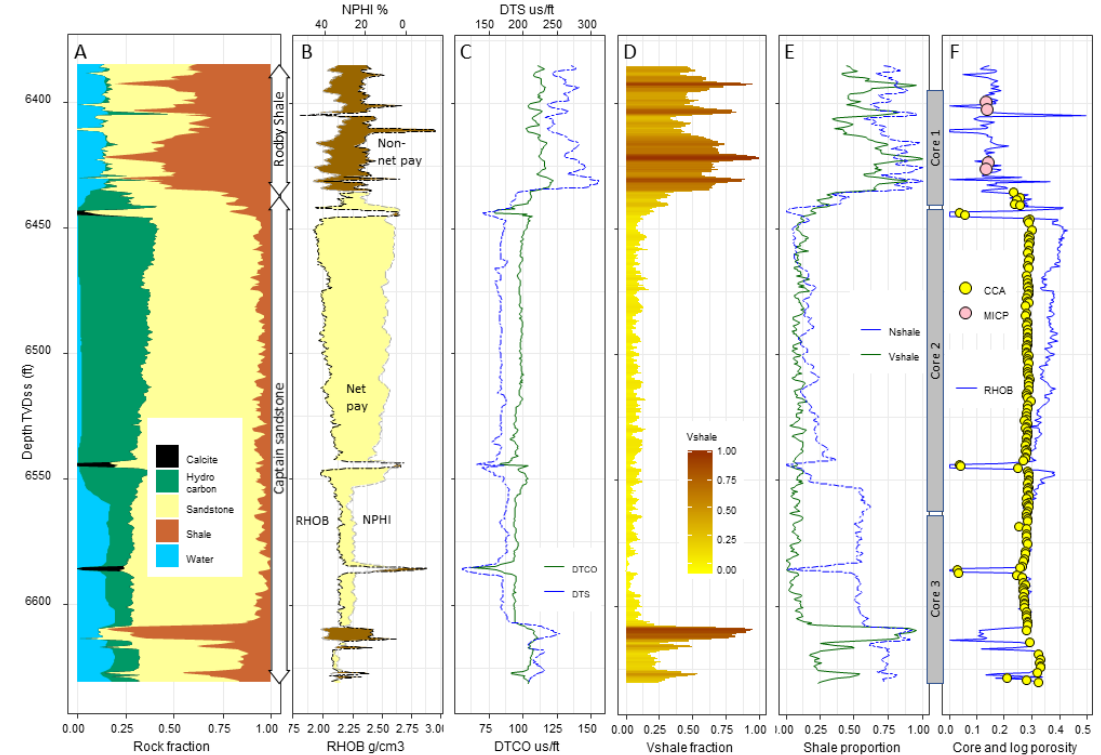
Figure 4. Wireline log raw and interpreted data from well 14/26a-8 from the Lower Cretaceous Acorn Storage Site. ( A ) Interpreted lithology and fluid saturation diagram showing the Captain Sandstone which is overlain by the top-seal of the Rodby Shale. In this well, the Rodby Shale seems to be very shale rich. The pre-production petroleum column extended up to beneath the Rodby Shale. The petroleum saturation seems to have been very high, suggesting that the top-seal was very effective. ( B ) Neutron-density crossover diagram confirming that the Rodby Shale is a good seal (non-net reservoir with extensive and wide crossover). ( C ) Sonic log data; compressional sonic (DTCO) and the compressional shear log (DTS). The higher ratio of DTS to DTCO in the Rodby Shale than the cleaner sandstone reflects the lower Young’s modulus in the shale than the sandstone. ( D ) Vshale representation based on gamma ray logs. The highest Vshale sections equate to the weakest rocks (compare D to C ). ( E ) Vshale compared to Nshale, where the latter is derived from the normalised difference between the neutron log and the density-derived porosity. Vshale represents the relative abundance of K-bearing clay minerals (and K-feldspar), whereas Nshale represents the sum total of all clay minerals (and any other H-bearing minerals). The slightly elevated Nshale compared to Vshale in the Rodby Shale suggests that there is a relatively high abundance of non-radioactive clay minerals, such as kaolinite or chlorite. ( F ) Density log-derived porosity (RHOB) compared to core analysis (CCA)- and mercury intrusion (MICP)-derived porosity showing that the density log porosity values are accurate and that the Rodby Shale has porosity values of approximately 14%. The very low porosity values in the Rodby Shale at approximately 6400 and 6415 ft are probably due to the presence of calcite cement.